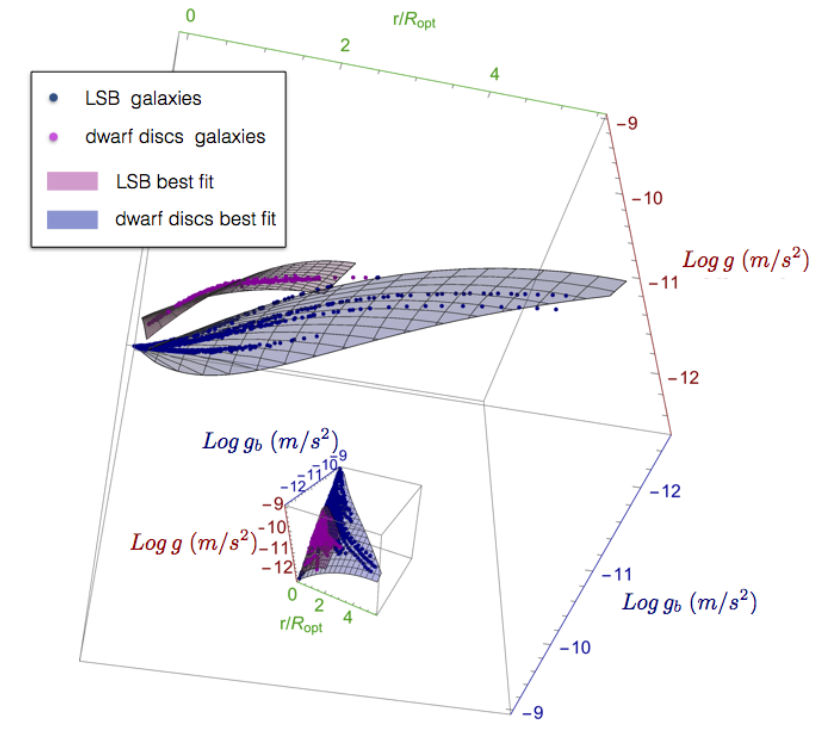
Figure 26. Total acceleration g vs. baryonic acceleration g b vs. normalised radii r / R opt . The magenta and blue points are the dd and LSB data. The magenta and the blue surfaces are the dd and LSB best fitting models. Image reproduced from